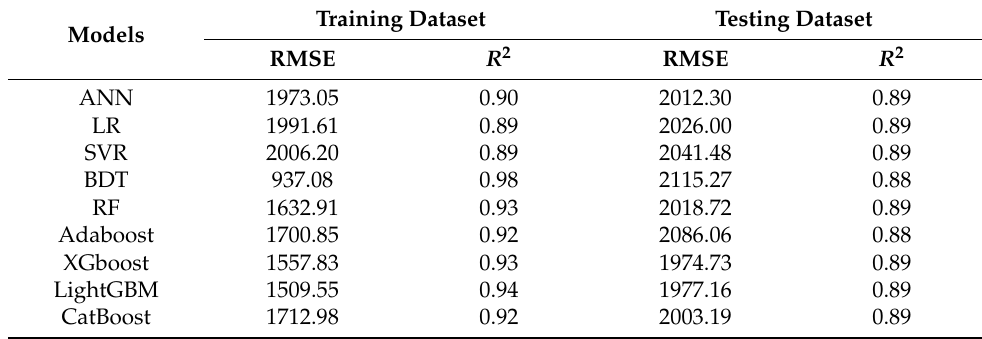
Table 3. Performance comparison of the individual ML models.